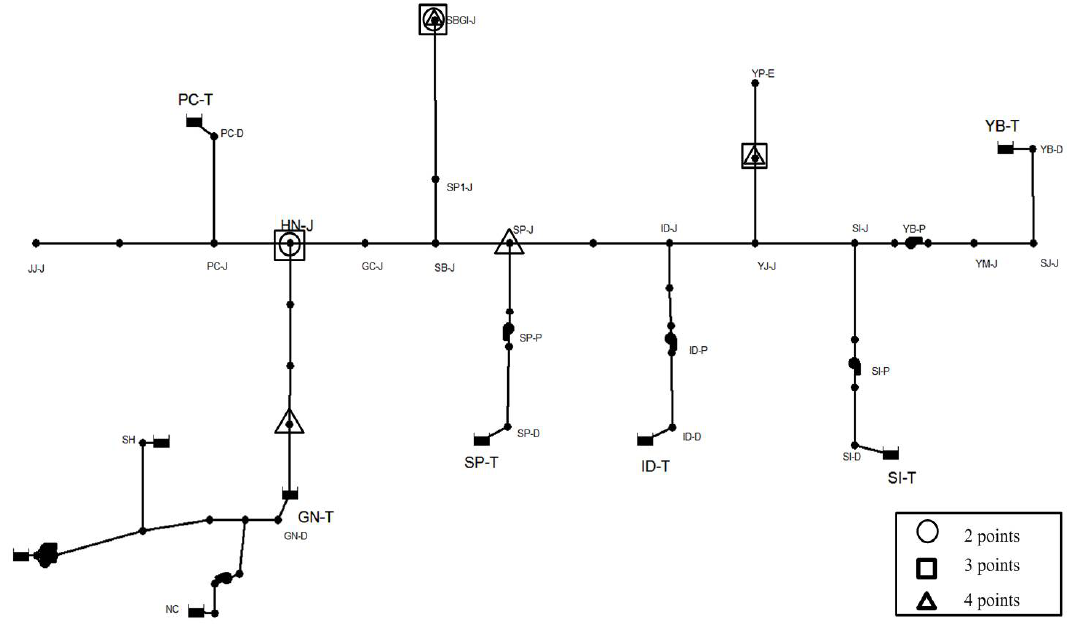
Figure 6. Locations of re-chlorination points for each scenario (P-City, network 1).